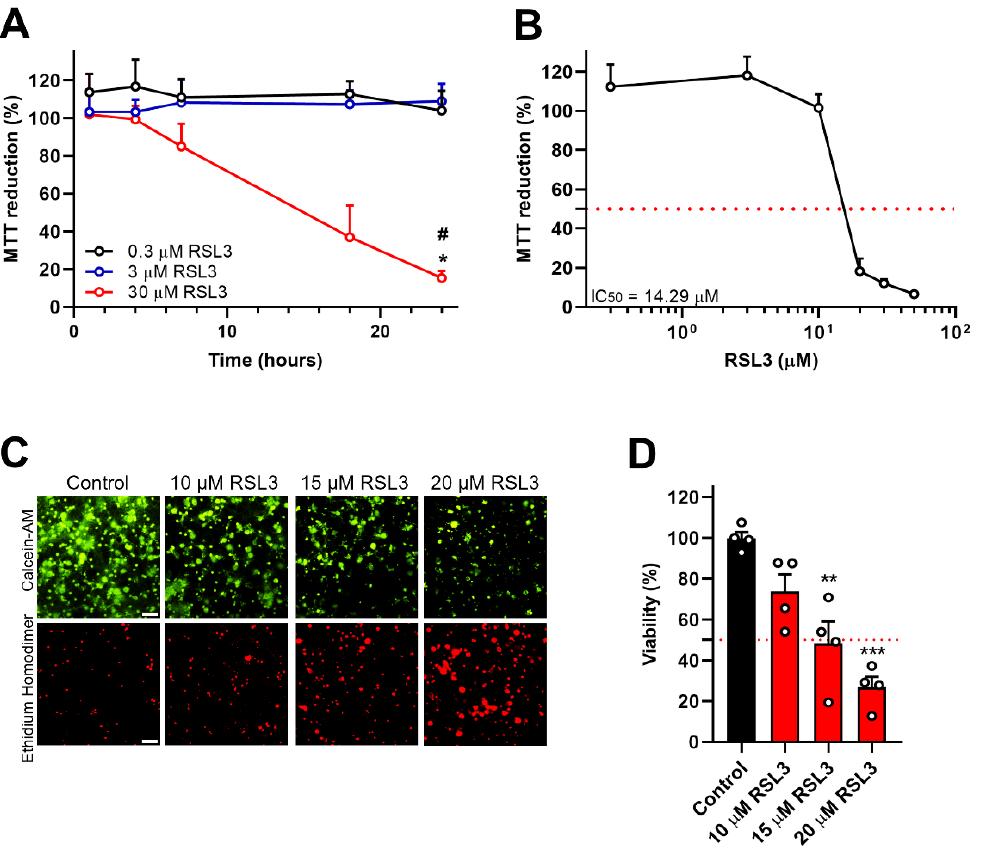
Figure 1 . GPX4 inhibition by RSL3 decreases the cell viability of primary hippocampal cultures. ( A ). Time-concentration dependence. Primary hippocampal cultures were incubated with 0.3, 3, or 30 µM RSL3 for different times, and metabolic cell viability was assessed by the MTT assay. N = 3 independent experiments, with each condition tested in duplicates. Statistically significant differ- ences among experimental conditions were evaluated by Two-Way ANOVA followed by a Bon- ferroni post-hoc test. * p < 0.0332 compared to the 0.3 µM RSL3 condition, # p < 0.0332 compared to the 3 µM RSL3 condition. ( B ). IC 50 definition. Primary hippocampal neurons were incubated for 24 h with different concentrations of RSL3, and metabolic cell viability was evaluated by the MTT assay. The IC 50 at 24-h incubation with RSL3 was 14.29 µM. ( C ) . LIVE/DEAD Viability/Toxicity Kit. Left: Representative images of primary hippocampal cultures incubated with DMSO (control) or 10, 15, or 20 µM RSL3 for 24 h and stained with calcein-AM (green) and ethidium homodimer (red). Scale Bar 50 µm. ( D ). Quantification of calcein positive cells, per the sum of calcein and ethidium homodimer positive cells, which reveals an IC 50 of 15 µM. In ( B , D ), values were normalized to control. Minimum N = 3 independent experiments, with each condition performed in triplicates. Statistically significant differences among experimental conditions were evaluated by One-Way ANOVA followed by Tukey’s multiple comparisons test. ** p < 0.0021, *** p < 0.0002 compared to control. 3.2. GPX4 Inhibition by RSL3 Induces Ferroptosis in Primary Hippocampal Cultures To further test if RSL3 treatment induced ferroptosis, primary hippocampal cultures were co-incubated with the iron chelator DFO or the ferroptosis inhibitor Fer1. Both the LIVE/DEAD Viability/Cytotoxicity Kit (Figure 2A,B) and the MTT assay (Figure 2C,D) revealed that the decrease in cell viability induced by RSL3 treatment was mitigated by previous incubation with DFO or Fer1. These protective effects positively correlated with increased DFO or Fer1 concentrations. Moreover, since lipid peroxidation is one of the hallmarks of ferroptosis, we tested with the redox-sensitive probe Bodipy C11 if RSL3 treatment increased lipid peroxidation. In the basal state, this probe displays red fluo- rescence (Em 590 nm); however, when its polyunsaturated butadienyl zone gets oxi- dized, its emission/excitation pattern changes towards green fluorescence (Em 510 nm). We found that after 24 h of RSL3-treatment, MAP2A-stained neurons displayed a signif-